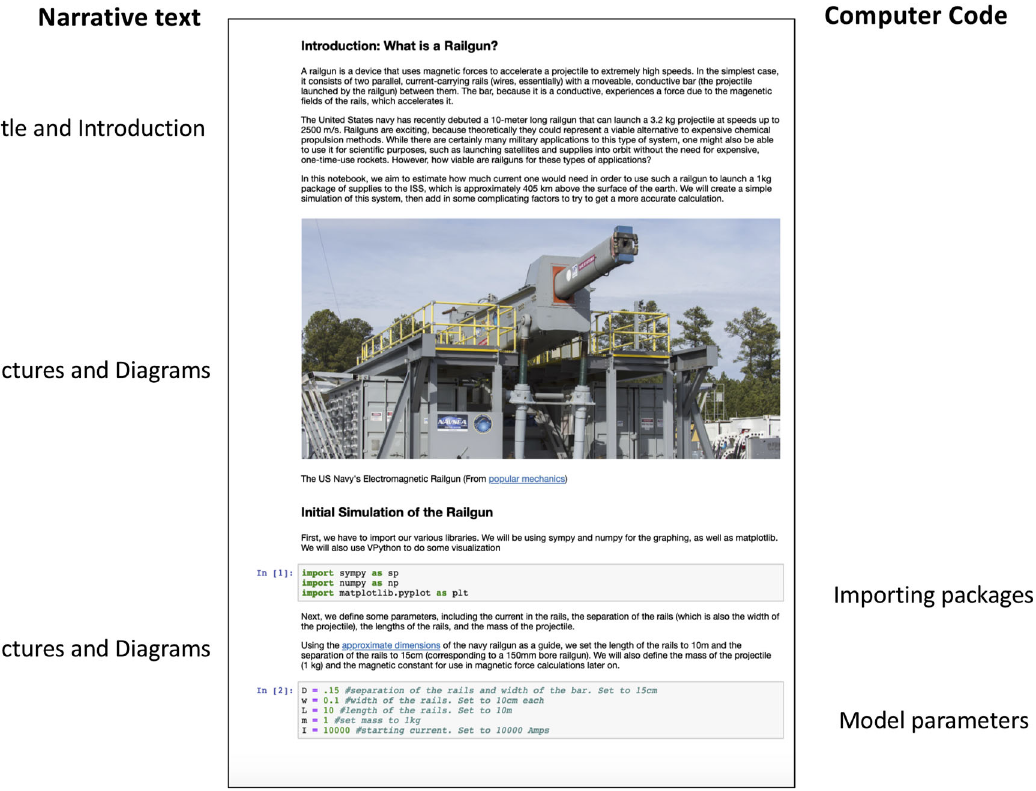
FIG. 2. Example computational essay, showing the mix of text, code, and pictures. Example essays and student essays are both available in Ref.